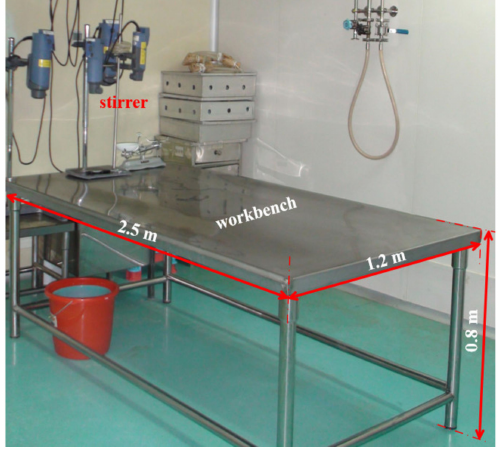
Figure 1. The large-area workbench prototype used in this